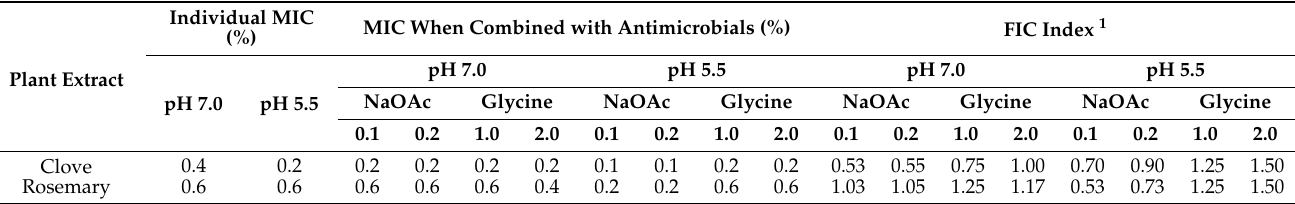
Table 5. Combined effects of ethanolic plant extracts with antimicrobials. Individual MIC (%) MIC When Combined with Antimicrobials Plant Extract